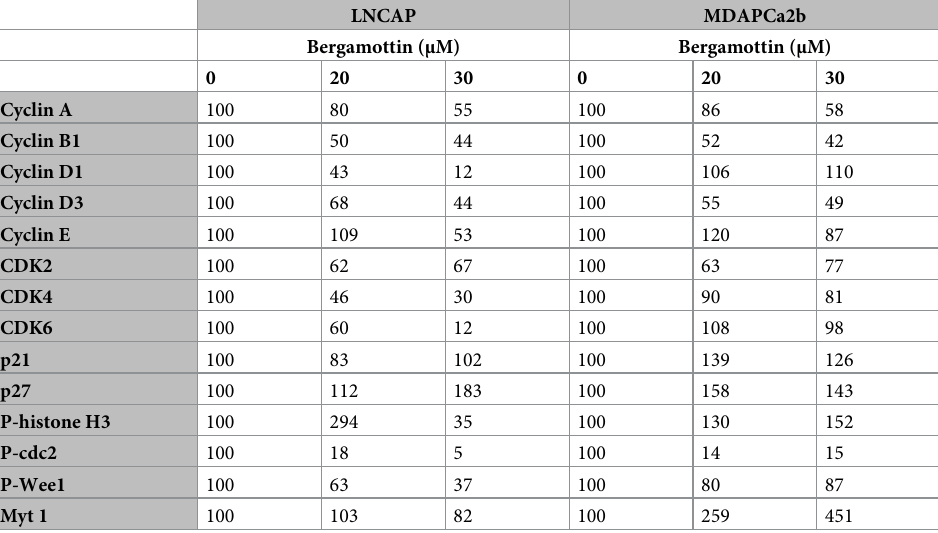
Table 2. Fold changes in cell cycle regulating proteins after bergamottin treatment.